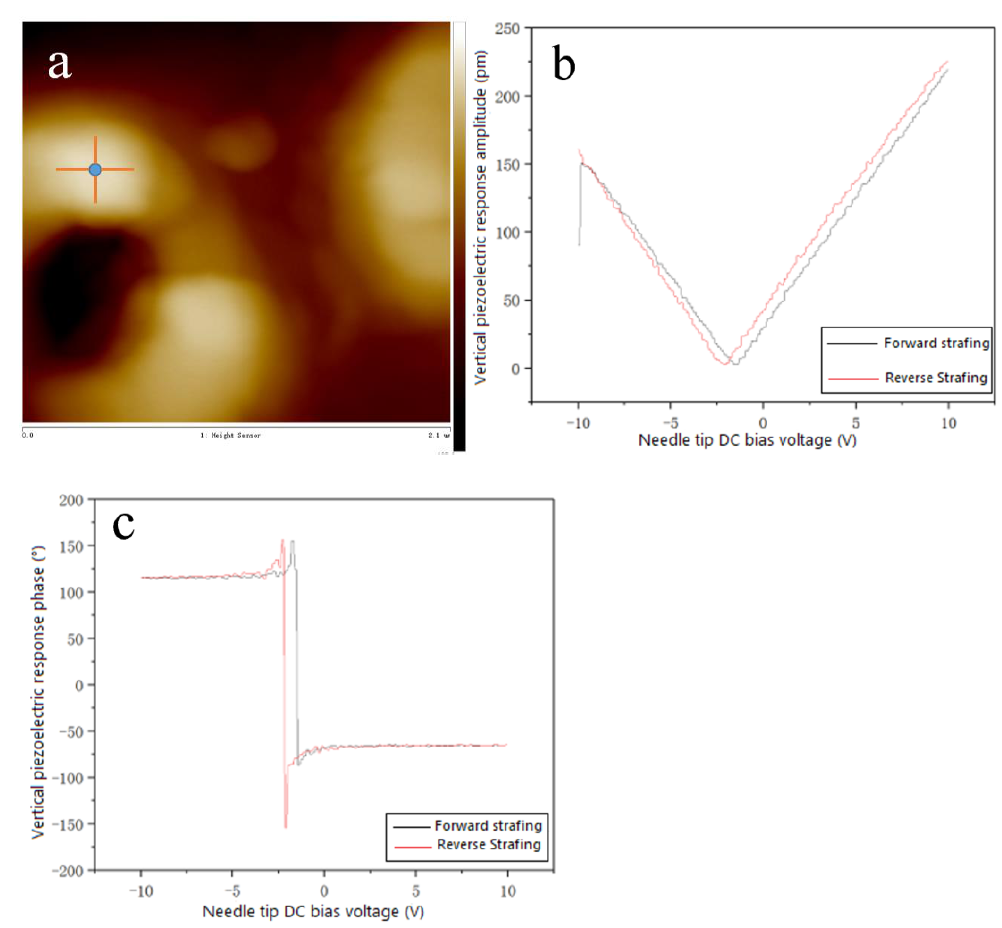
Figure 5. Vertical piezoelectric response hysteresis curve based on (ATHP) 2 PbBr 4 piezoelectric film. ( a ) high-resolution topography, ( b ) piezoelectric response amplitude hysteresis curve in the vertical direction, ( c ) piezoelectric response phase hysteresis curve in the vertical direction